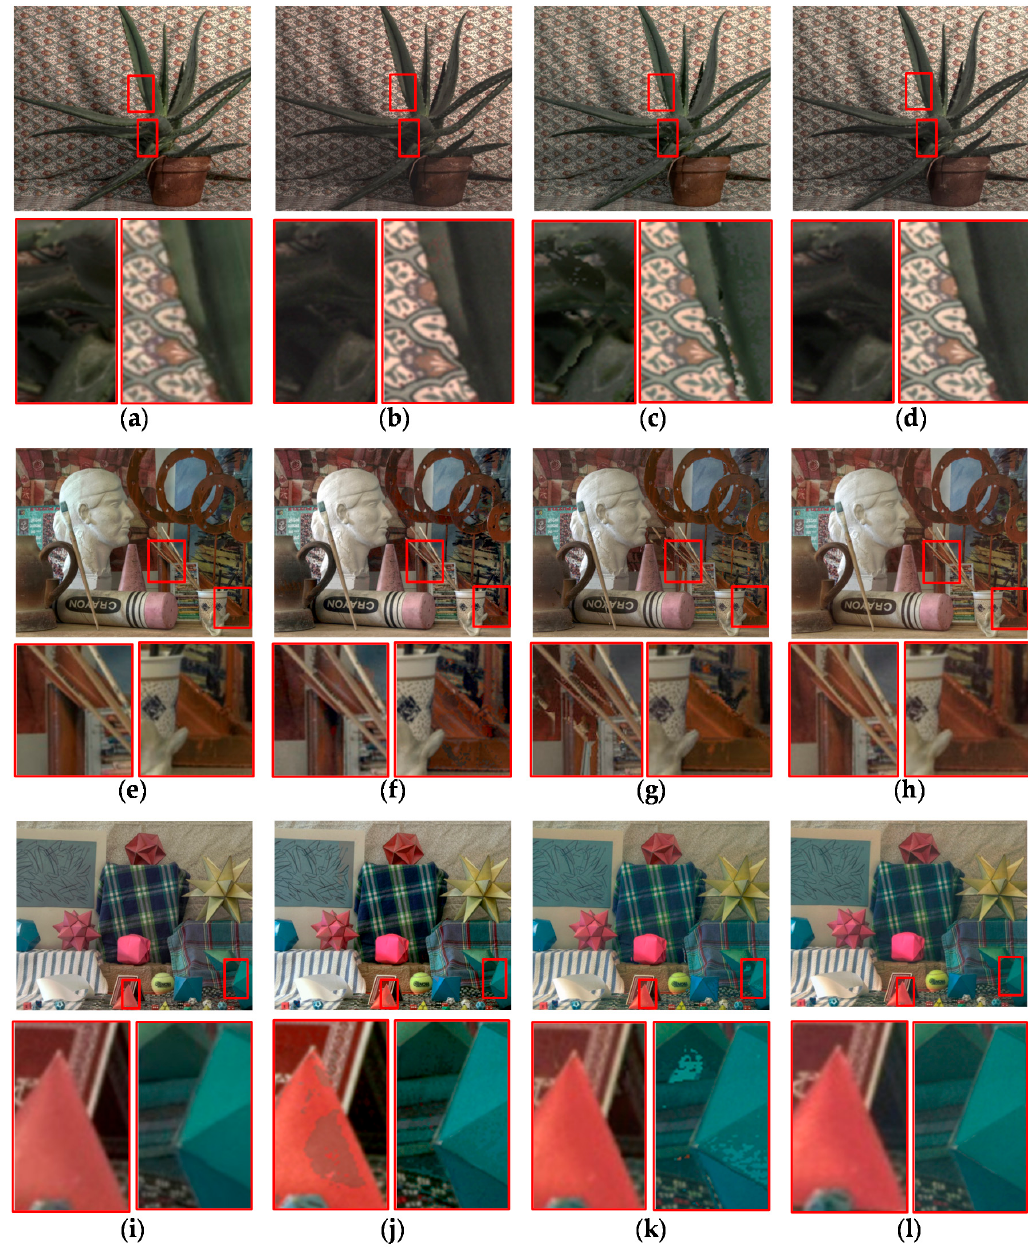
Figure 19. Resultant LDR images for the Middlebury database with short-long exposure: ( a , e , i ) reference image; ( b , f , j ) Lin and coworkers’ method [14]; ( c , g , k ) Batz and coworkers’ method [16]; and ( d , h , l ) proposed method.